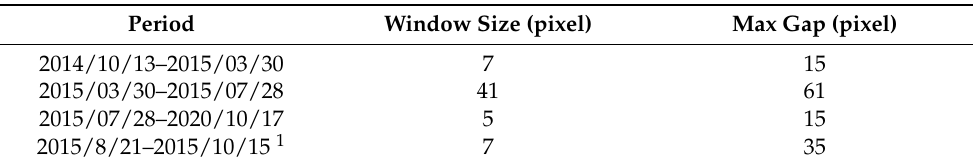
Table 2. Window size and max gap (the greatest distance a pixel may shift in either vertical or horizontal) of cross-correlation in the different phases.